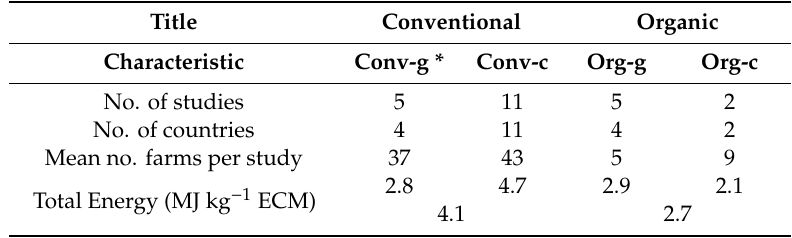
Table 1. Mean energy consumption and characteristics of studies found in literature. Title Conventional Organic Characteristic Conv-g